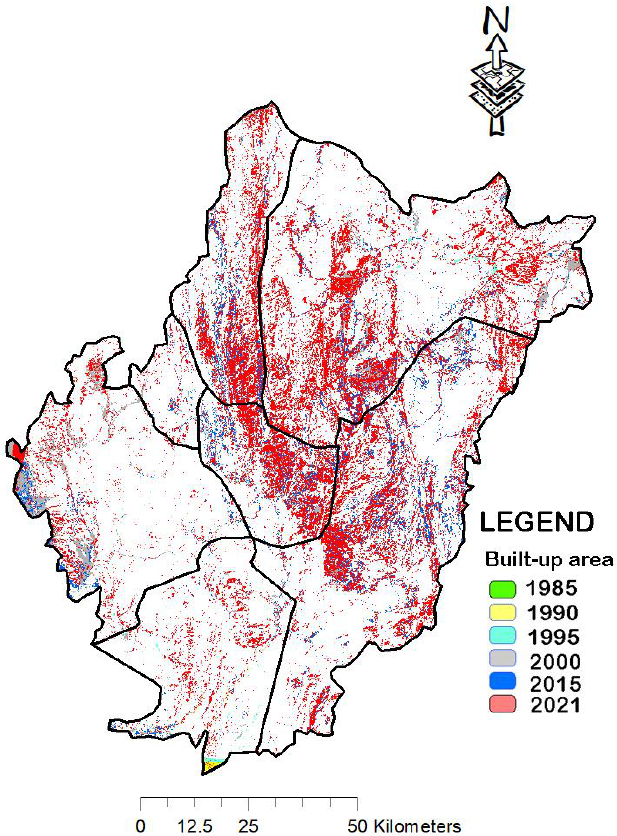
2 ) for the years: 1985, 1990, 1995, 2000, 2015, and 2021.